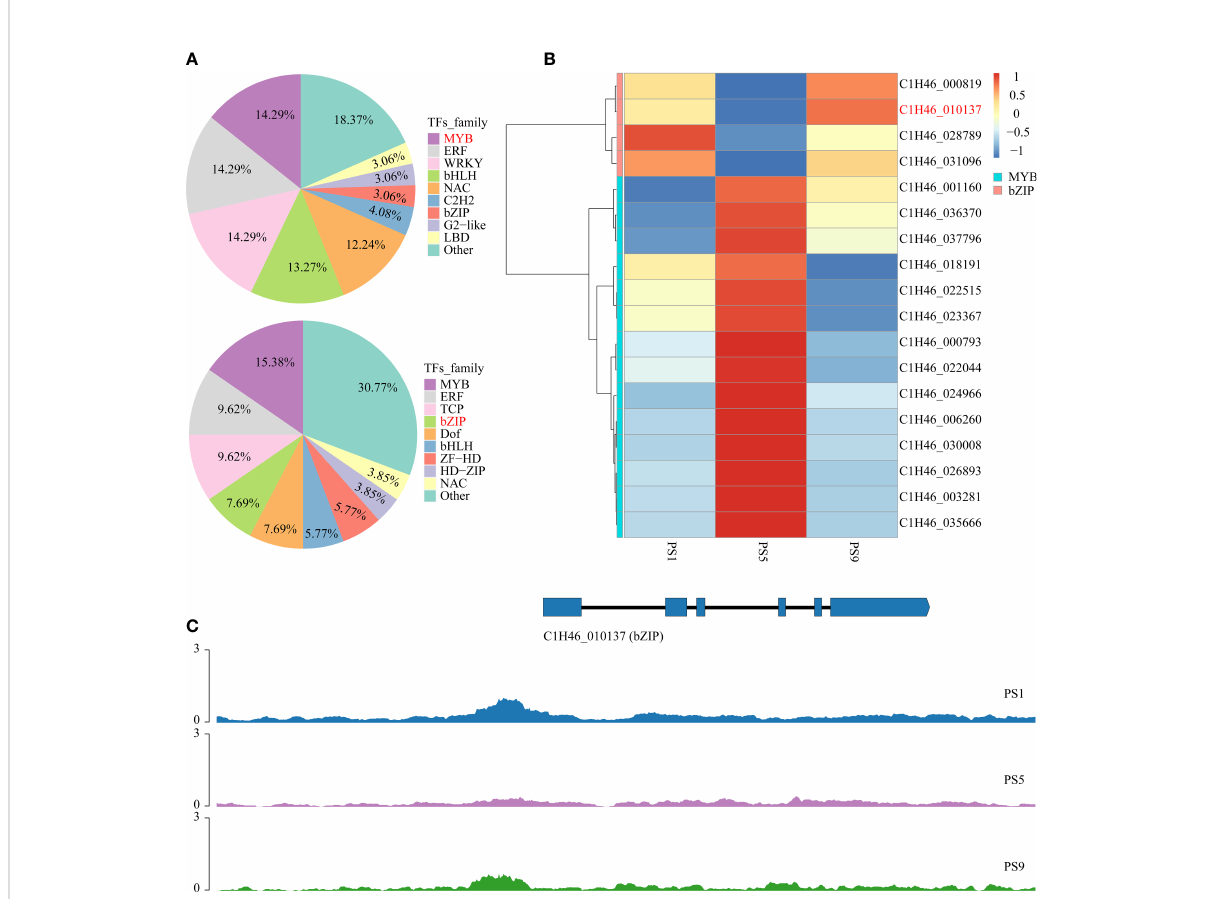
FIGURE 4 Candidate TF genes that play roles in the competition for anthocyanins and quercetins biosynthesis. (A) Frequencies of the transcription factor gene families in all the differentially expressed transcription factor genes; (B) Heatmap of differentially expressed MYB and bZIP genes that showed adverse change patterns in comparison PS5_vs_PS1 and comparison PS9_vs_PS5. (C) Chromatin accessibilities of a bZIP gene (C1H46_010137) at three different ripening